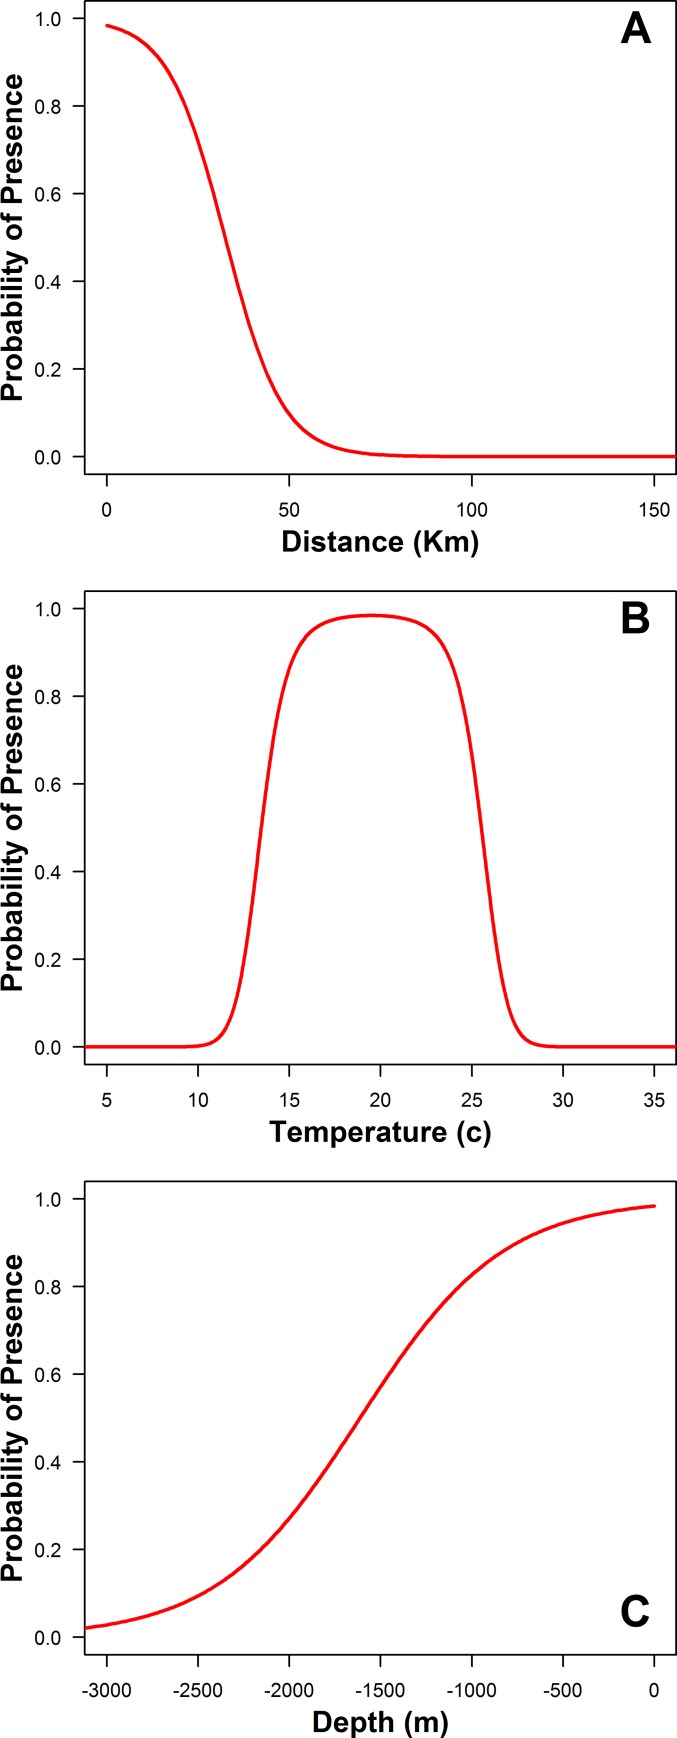
Habitat suitability by environmental parameters.Presences (standardized daily positions) are shown as black circles with a value of 1, while available points are shown as a having a value of 0. Values are plotted against distance to land (A), temperature (B) and depth (C). Conditional predicted responses for each variable are displayed as red lines by fixing the other two parameters.